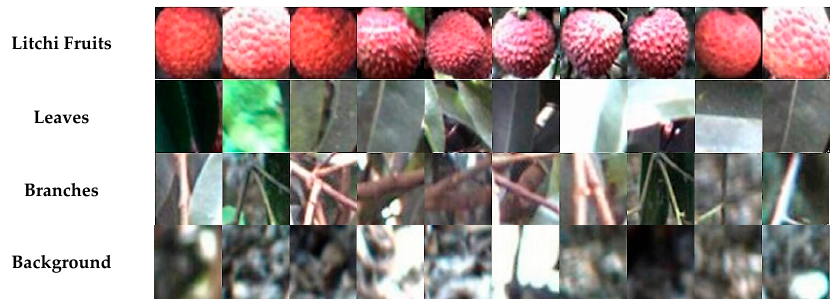
Figure 5. Examples of the dataset images. The top row listed the images of mature litchi fruits captured under the natural condition, and the lower rows were leaves, branches and background.